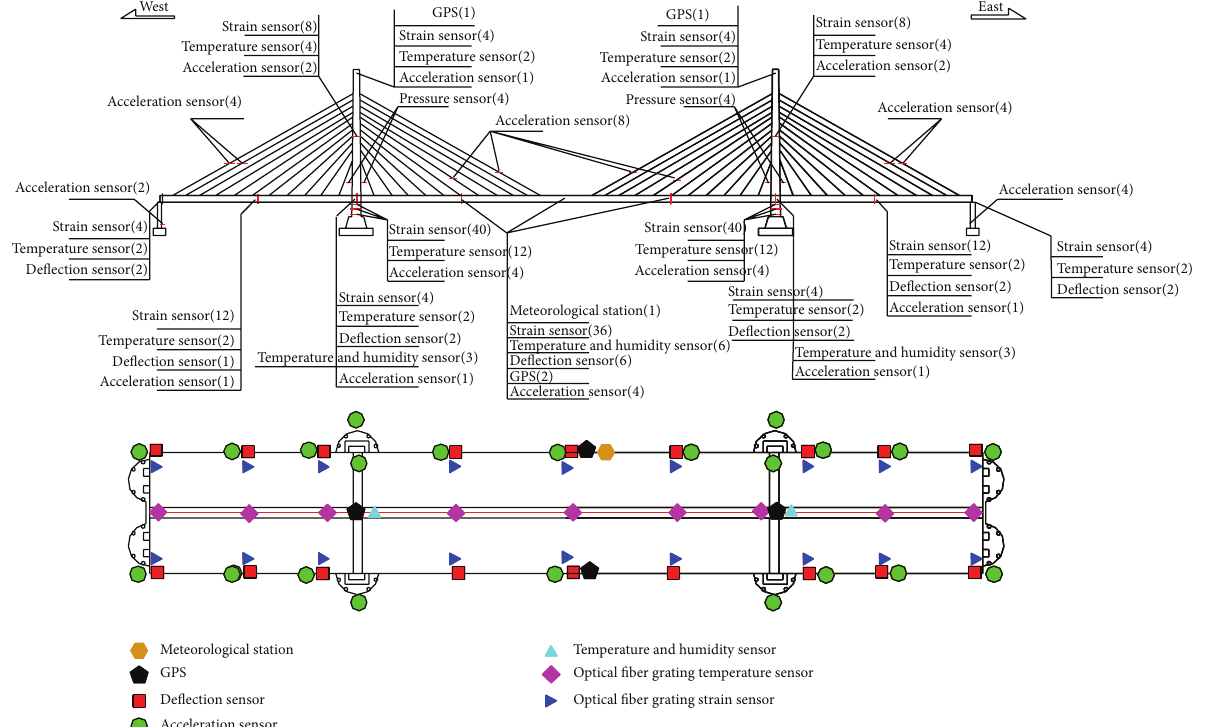
Figure 3: Layout of sensors on Zhijiang Bridge.